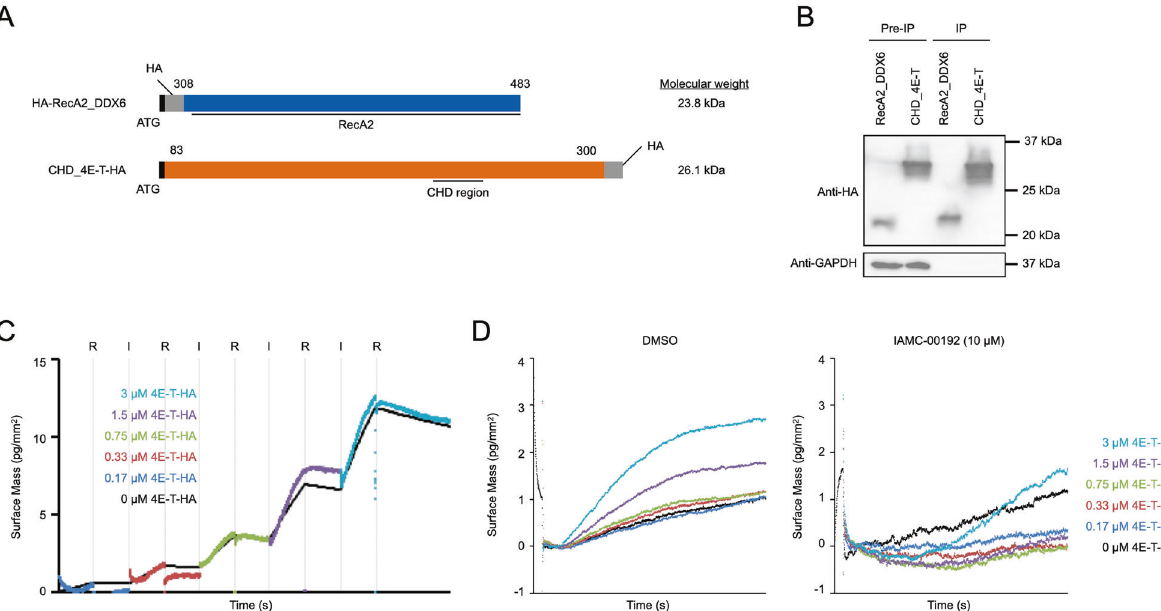
Fig. 3 Protein-protein interaction analysis using Creoptix WAVEsystem and inhibitor candidate molecules. A Design of proteins for use in measuring protein-protein interactions. B Expression and puri fi cation con fi rmation of the designed protein. The protein was immunoprecipitated with HA antibody and veri fi ed by Western blotting. C Measurement of changes in binding strength due to changes in the concentration of CHD_4E-T protein. R Rinsing the sensor with buffer, I Injection of analyte proteins. D Measurement of the change in binding strength when the RNA degradation inhibitor IAMC-00192 is